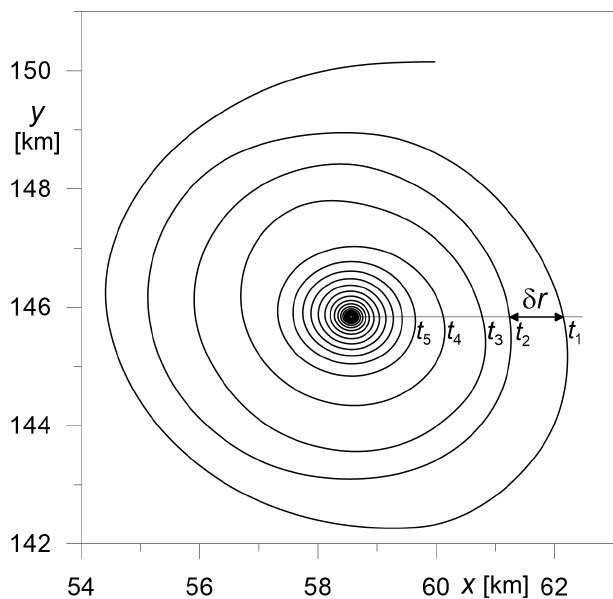
Figure 3. An example pseudo-trajectory for a synthetic floating par- ticle deployed in a submesoscale eddy. The pseudo-trajectory was calculated using a surface velocity field in the southeastern Baltic Sea simulated for the time moment 15 May 2015, 12:00UTC (the frozen field approach). The particle was released in the periphery of the submesoscale cyclonic eddy c1 (see Fig.